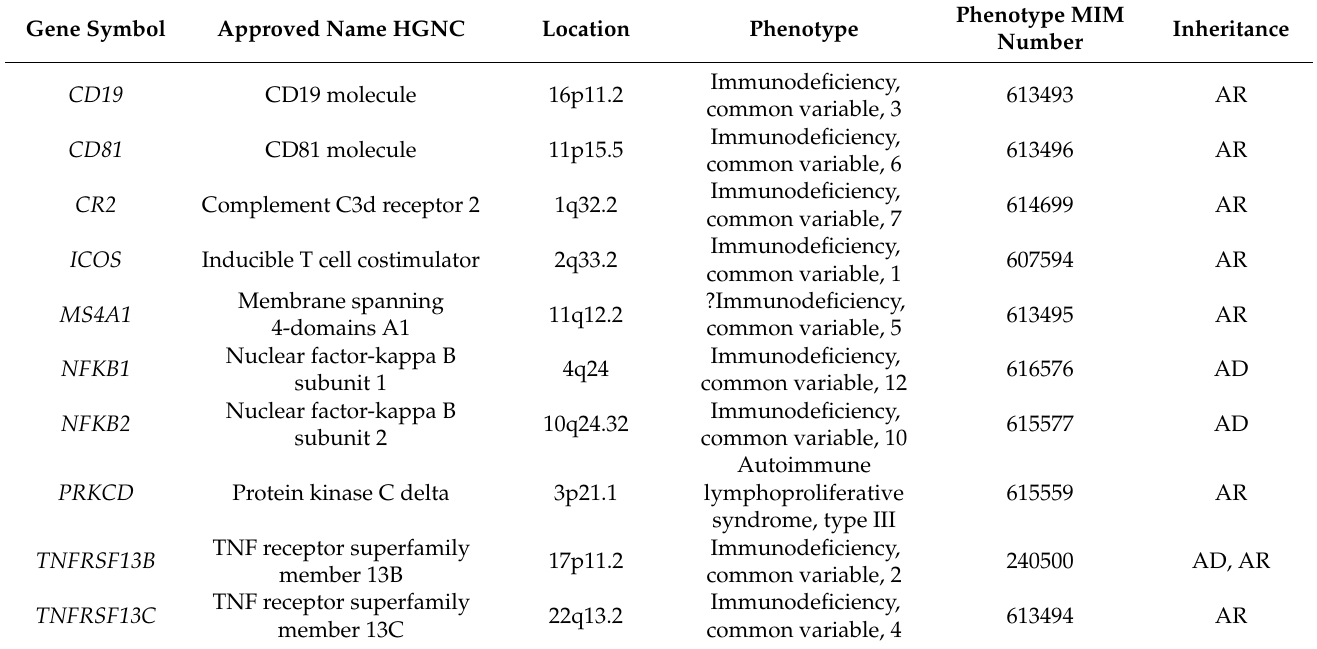
Table 2. Genes associated with the disease term “Common Variable